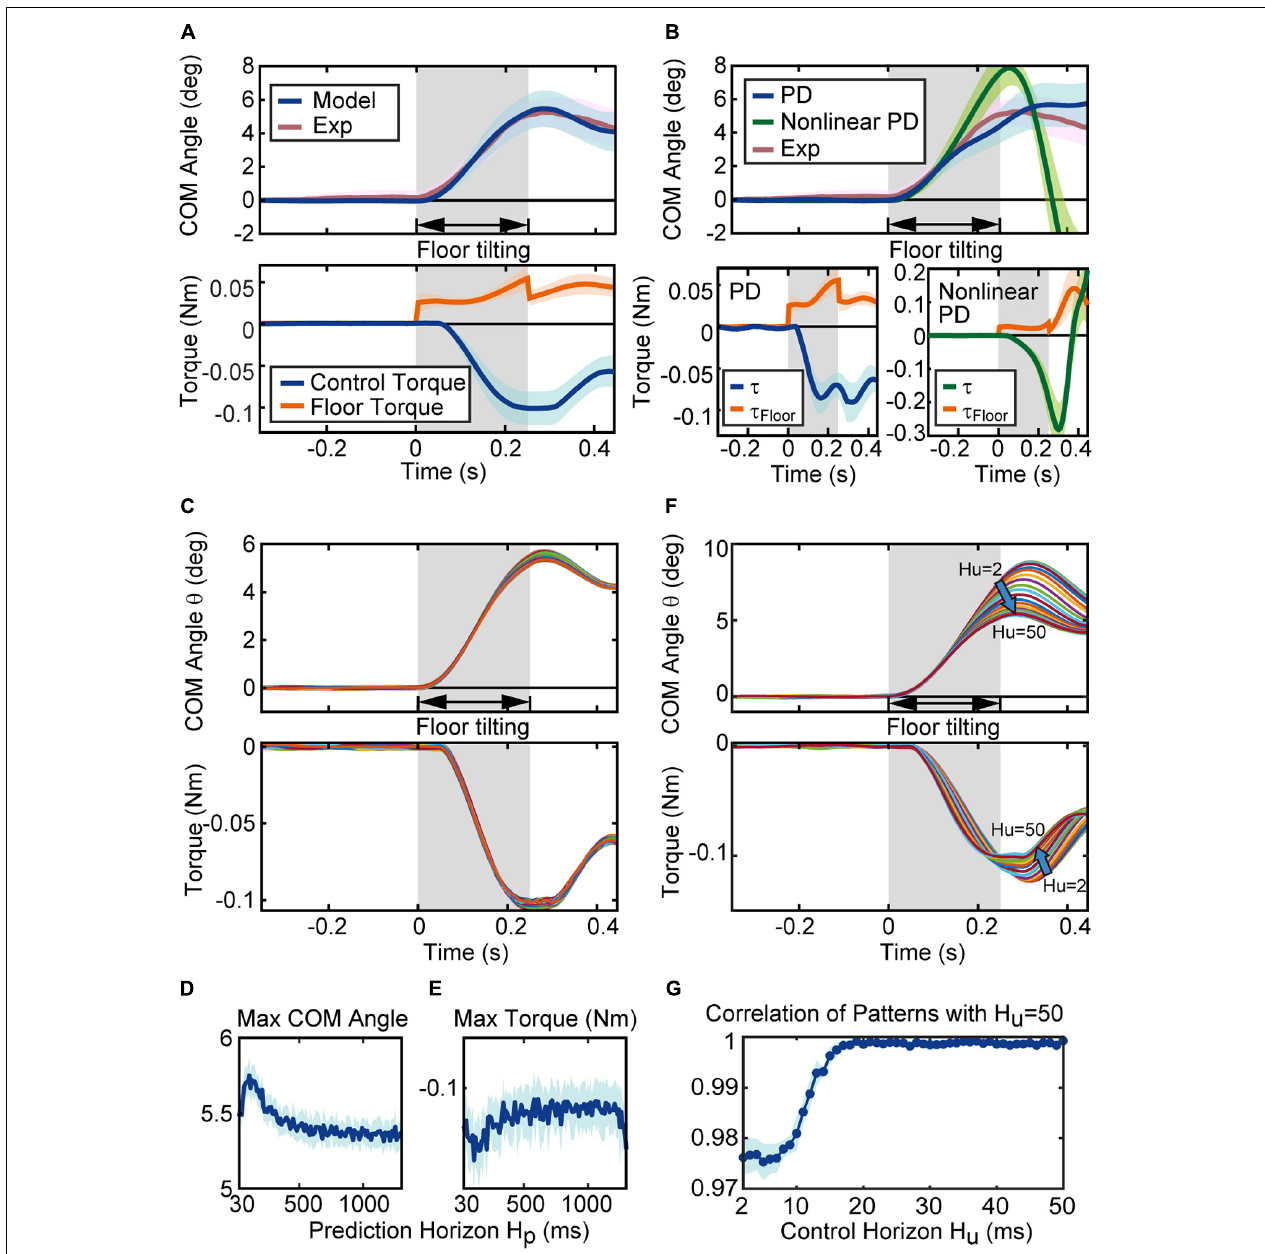
FIGURE 5 | Behavior of the proposed mathematical model. (A) Simulation results of the model. The blue and red lines in the figure of CoM angle are the average of the CoM angles for the 17 simulated (Model) and experimental (Exp) sequences. The blue and red regions represent their standard deviation (SD). The blue and orange line in the torque figure represent the average of the control torque τ and the floor torque τ Floor , respectively. The surrounding blue and orange regions represent the associated SD. (B) Simulation results of the conventional models. Blue lines, green lines and red lines in the figure of CoM angle are the average results of the PD controller with Peterka’s gain parameters, the average results of the non-linear PD controller for standing rats, and the average of the experimental sequences, respectively. Blue, green, red regions represent their SD. The blue, green, and orange line in the figure of torque represent the average of the control torque τ and the floor torque τ Floor , respectively. The blue, green and orange regions represent their SD. (C) Time series of the CoM angle and torque with different prediction horizons. Each line in the figure is the simulation result of the model with a prediction horizon from 30 ms to 1,300 ms (average of ten simulation results with same parameters). The maximum CoM angle and the maximum torque for each parameter are shown in (D,E) , respectively. (D,E) Are the results for one sequence, and Supplementary Figure 2 shows the results for complete sequences. (F) Time series of the CoM angle and torque with the control horizon from 2 ms to 50 ms. Each line is the average of ten simulations with the same prediction horizon. (G) The correlation coefficient (cosine correlation) between the time series of the CoM angle (average of ten trials) with control horizon 50 ms and the time series of the CoM angle with each control horizon. The line is the average of ten correlation coefficients for each control horizon, and the area represents SD. (G) Is the results for one sequence, and Supplementary Figure 2 shows the results for complete sequences.